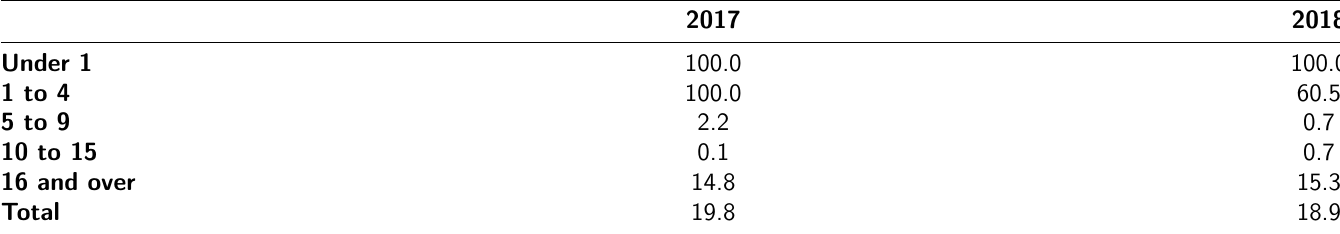
Table 2: Percentage missingness per age group per year for the CRCS